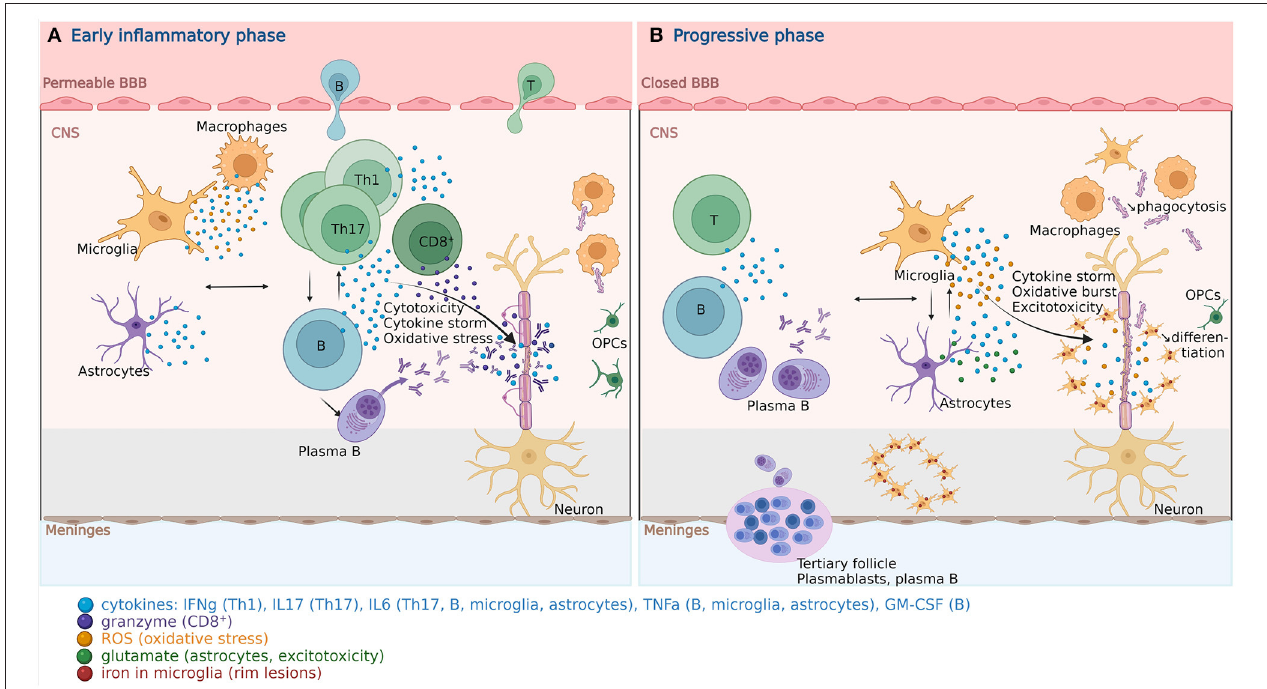
FIGURE 1 | Pathophysiology of multiple sclerosis. (A) In the early inflammatory phase of MS, peripheral adaptive immune cells infiltrate the CNS through a disrupted BBB. These activated cells interact with each other and the resident cells of the CNS. They secrete cytokines (e.g., IFNg by Th1, IL6/17 by Th17, GM-CSF, IL6, TNFa by B cells) and cytotoxic molecules (e.g., granzyme B by CD8 + T cells). B cells can further evolve into autoantibody-producing plasma cells. As a consequence, T and B cells activate macrophages and microglia, which produce cytokines, nitric oxide, and ROS. This cytotoxic pro-inflammatory environment breaks down the myelin sheaths around axons and induces energy failure in the axon. Macrophages and microglia can still clear the myelin debris, allowing for the recruitment of OPCs that will partially remyelinate the lesion. (B) In the progressive phase of MS, T and B cell infiltrates are reduced. Remarkably, plasmablasts and plasma B cells form tertiary follicle-like structures in the meninges. The BBB is closed and the inflammation is sustained by innate CNS-resident cells, i.e., microglia and astrocytes. They produce cytokines (TNFa, IL6) and release ROS, causing myelin damage. Although microglia are primed into a pro-inflammatory phenotype, their phagocytic capacities are reduced. These features also characterize the senescence-associated phenotype of microglia and astrocytes. Myelin debris are improperly cleared, OPCs are less recruited and fail to differentiate. TNFa-mediated glutamate release from astrocytes results in excitotoxicity causing axonal damage. The ferrous iron released from the myelin, where it accumulates with age, is oxidized, which produces ROS, and incorporated by microglia, forming a phenotypical rim around the demyelinating lesions, both in the white and gray matter. These successive events are self-sustained and enhanced by senescent processes, resulting in a major oxidative burst, causing mitochondrial dysfunction, mitochondrial DNA damage, energy failure and axonal loss. BBB, blood brain barrier; B, B cell; CNS, central nervous system; GM-CSF, granulocyte-macrophage colony-stimulating factor; IFN, interferon; IL, interleukin; MS, multiple sclerosis; OPC, oligodendrocyte progenitor cell; ROS, reactive oxygen species; T, T cell; Th, T helper cell; TNF, tumor necrosis factor. Created with